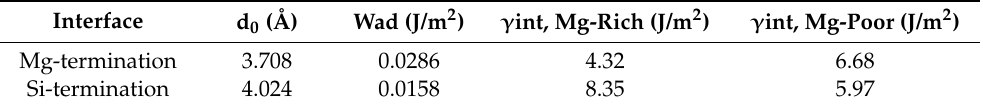
Table 4. The interfacial spacing of complete relaxation of Mg 2 Si (111)/Gr (0001) interfaces and the corresponding work of adhesion and interfacial